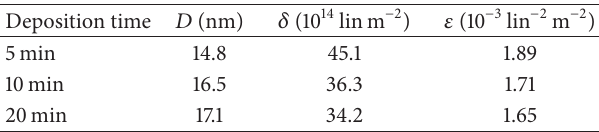
Table 1: Structural parameters (crystalline size, dislocation density, and lattice microstrain) of the Ag NPs film deposited at different deposition